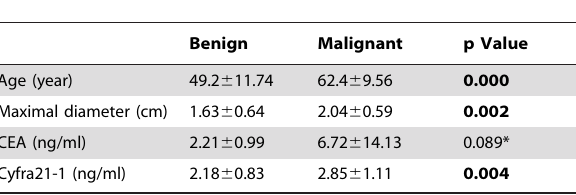
Table 3. Univariate analysis of quantitative factors.